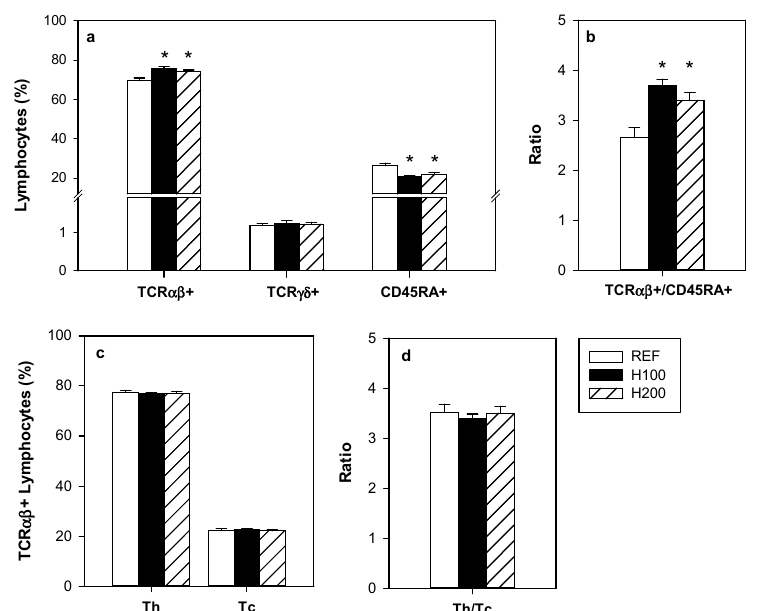
Figure 3. Effect of hesperidin administration on the proportion of mesenteric lymph node lymphocytes. ( a ) TCR αβ +, TCR γδ + and CD45RA+ lymphocytes; ( b ) TCR αβ +/CD45RA+ ratio; ( c ) Th (TCR αβ +CD4+) and Tc (TCR αβ +CD8+) lymphocytes; and ( d ) Th/Tc ratio. Data are expressed as mean ± standard error ( n = 5–6). Statistical difference: * p < 0.05 versus REF group (one-way ANOVA).